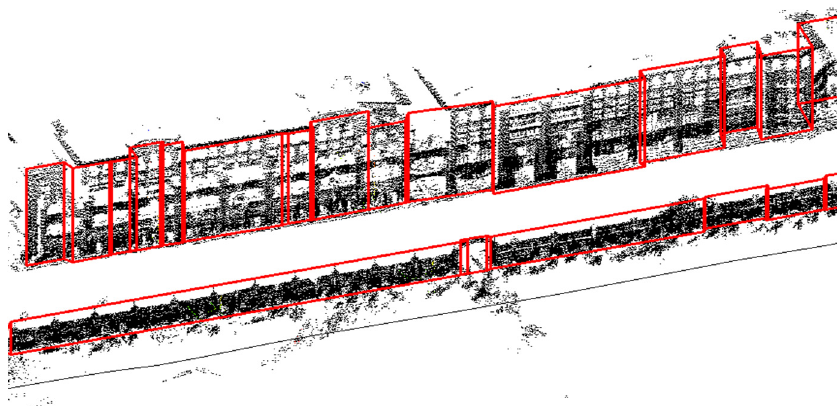
Figure 16. Overlaid image of extracted building façade and point cloud.